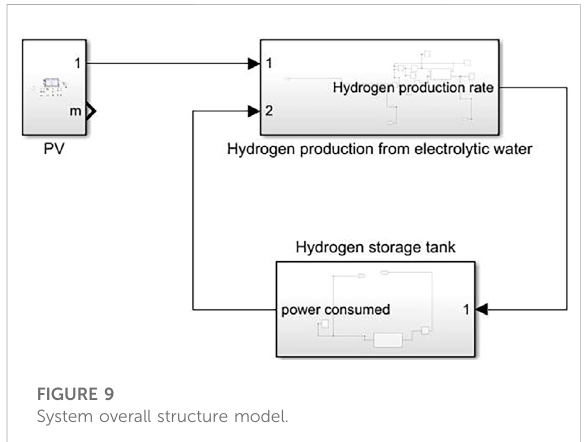
FIGURE 9 System overall structure